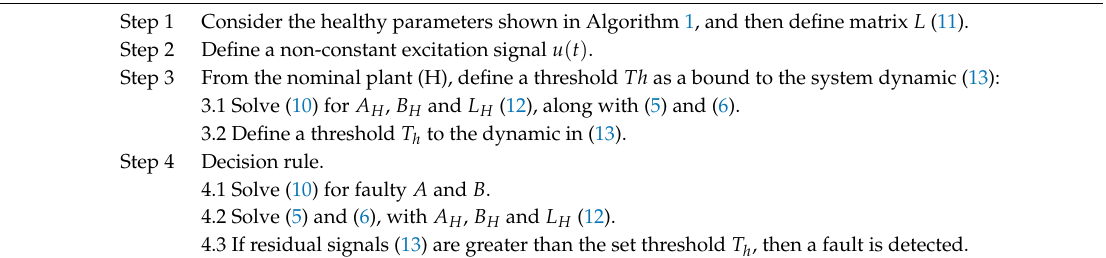
Algorithm 2: Wind turbine fault detection algorithm (FD-Algorithm)